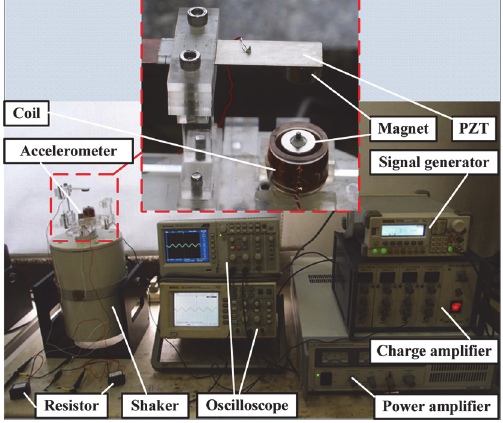
Figure 8. Prototype of the HEH and the experimental system.